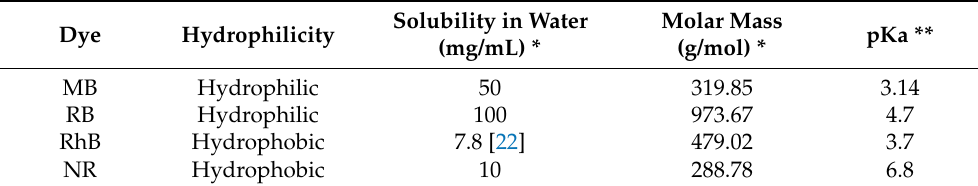
Table 1. Properties of the dyes used to load the SF